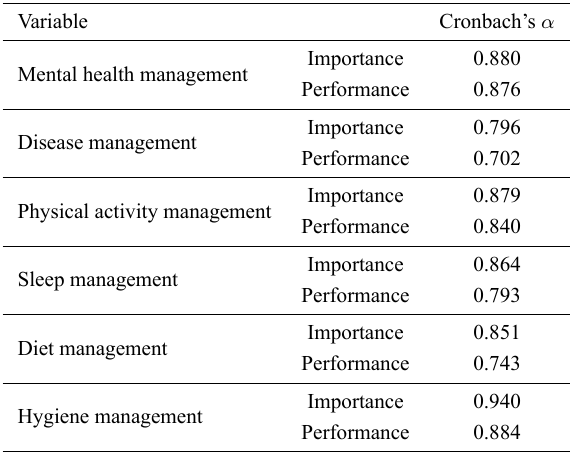
Table 2. Reliability